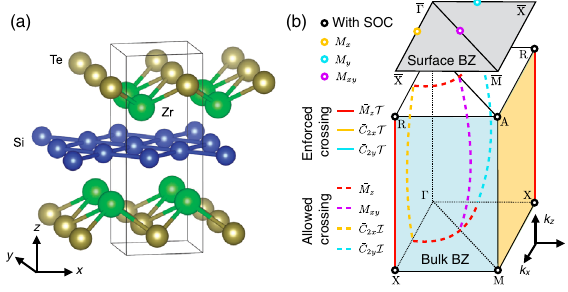
FIG. 1. (a) Crystal structure of ZrSiTe. Si atoms are displayed in blue, Zr in green, and Te in brown. (b) Brillouin zone and crossings enforced or allowed by the space-group symmetries of P 4 =nmm